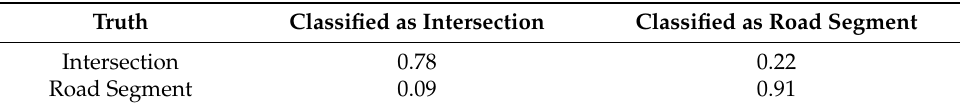
Table 6. Binary classifier based on thinning